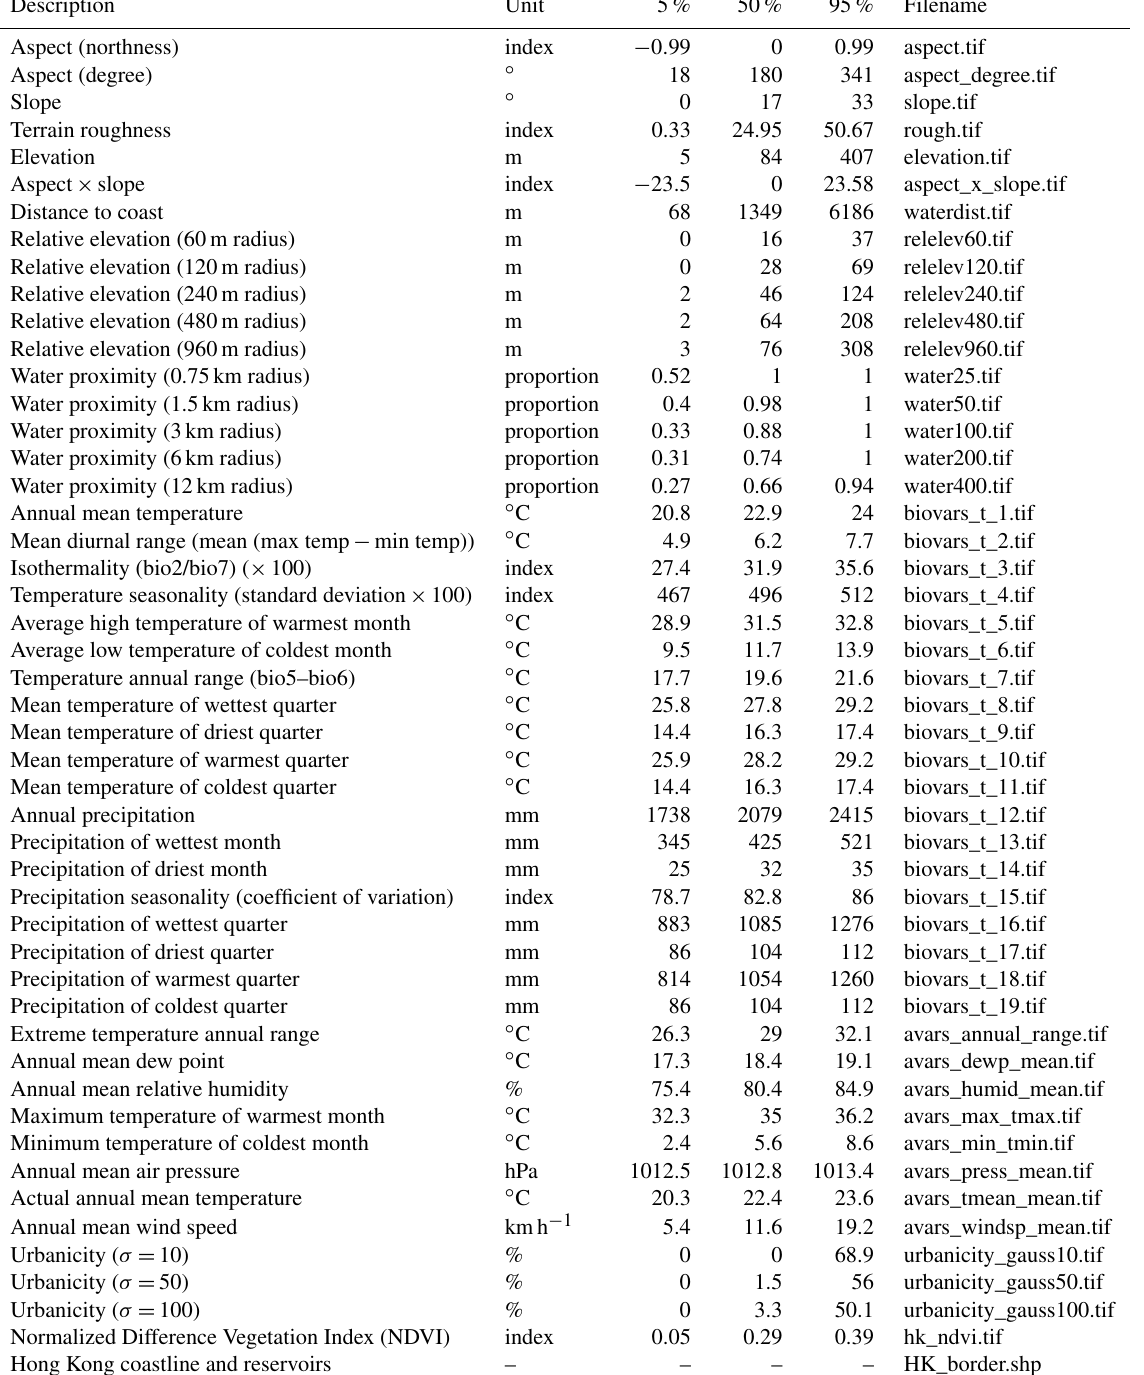
Table 1. Raster product descriptions, units, and 5th, 50th, and 95th percentile